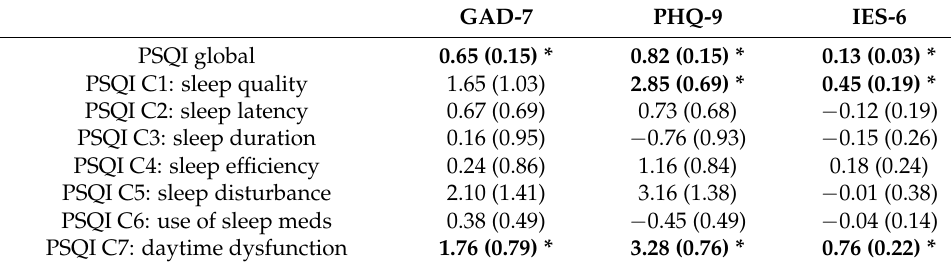
* Indicates significant at alpha 0.05 level. Values are represented as β (SE). β = regression coefficient (represents the slope of the linear relation of the predictor variable and the outcome variable), SE = standard error. Acronyms: PSQI = Pittsburgh Sleep Quality Index. Table 5. Regression table between Sleep quality and outcome variables.